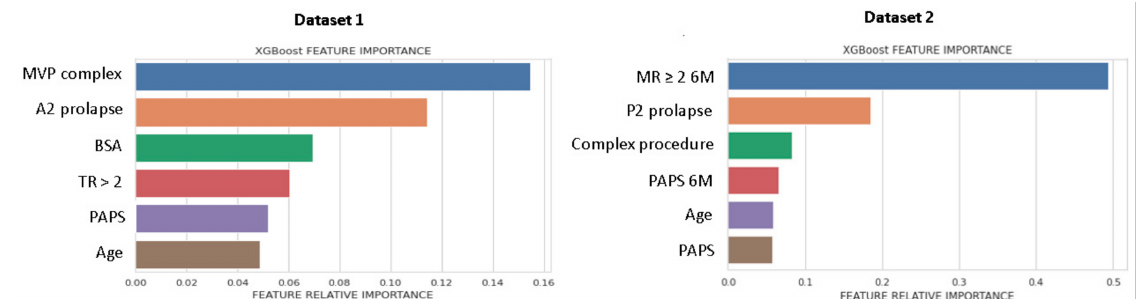
Figure 2. Feature importance plot for DS1 and DS2. Feature importance was measured as the Gini index. MVP, mitral valve prolapse; BSA, body surface area; TR, tricuspid regurgitation > 2; PAPS, systolic pulmonary artery pressure; MR, mitral valve regurgitation; 6M, six months.